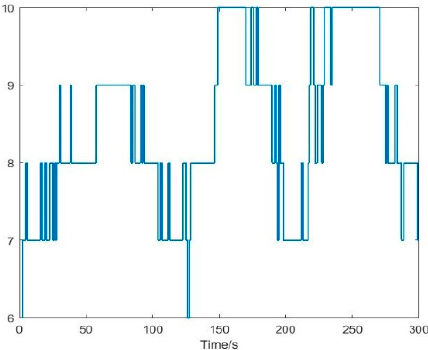
Figure 8. Number of available satellites during the real driving.